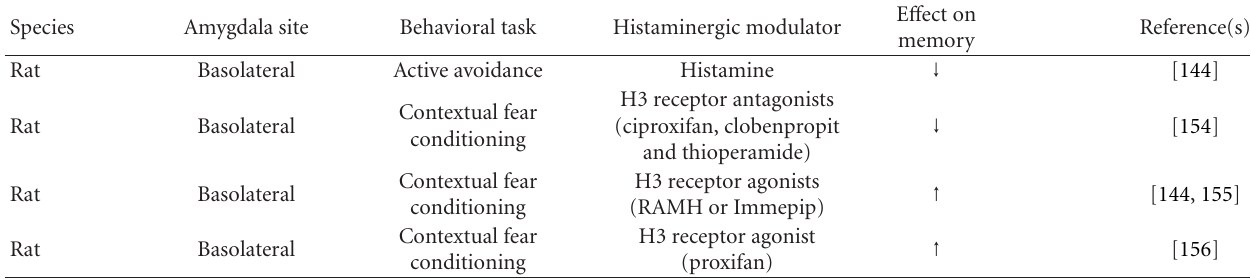
Table 5: Administration of drugs that act on the histaminergic system into the amygdala and memory performance. Species Amygdala